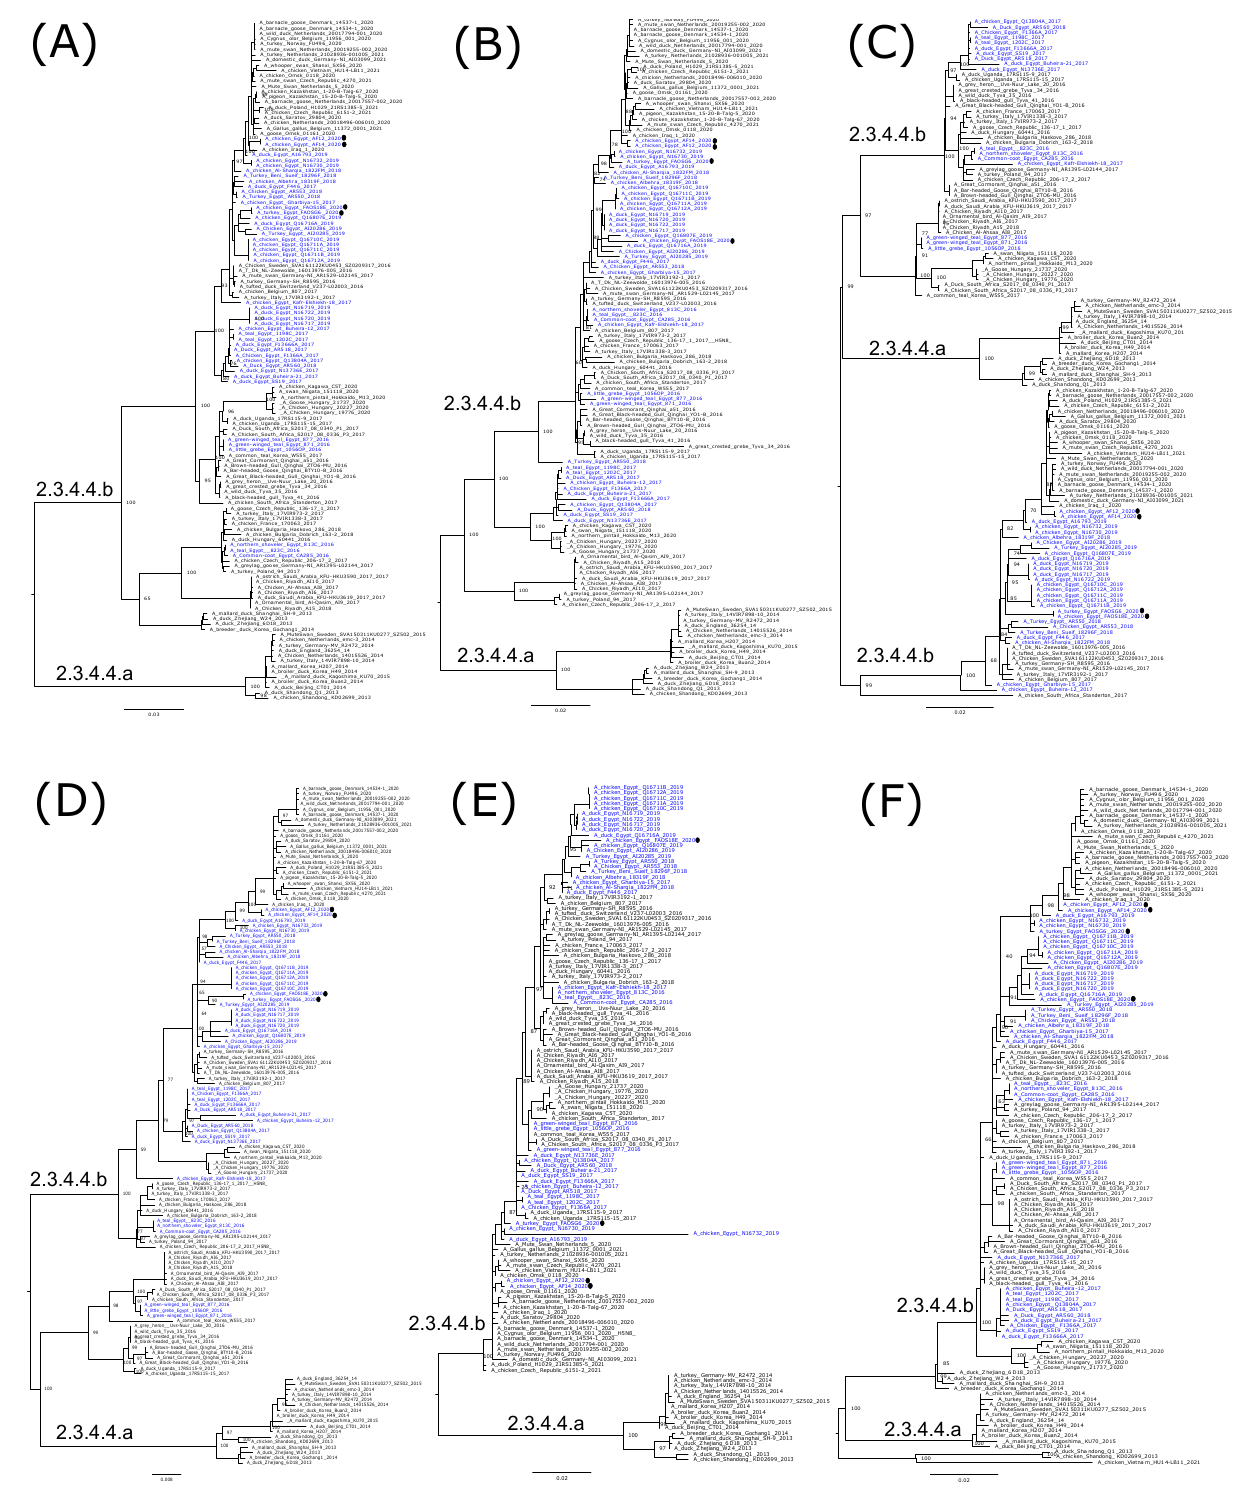
Figure 3. Phylogenetic relationships of the PB2 ( A ), PB1 ( B ), PA ( C ), NP ( D ), M ( E ), and NS ( F ) gene segments of Egyptian and representative H5N8 viruses. Egyptian H5N8 viruses are colored in blue, and viruses generated by the whole genome sequence in this study are shown by black dots. Trees were generated, after the selection of the best-fitted model, by employing maximum likelihood methodology based on the Akaike criterion using IQ-tree software version 1.1.3 [29]. Molecular clock-based trees were generated based on the HA and NA gene segments, as well as concatenated sequencing of the whole gene segments. As we described